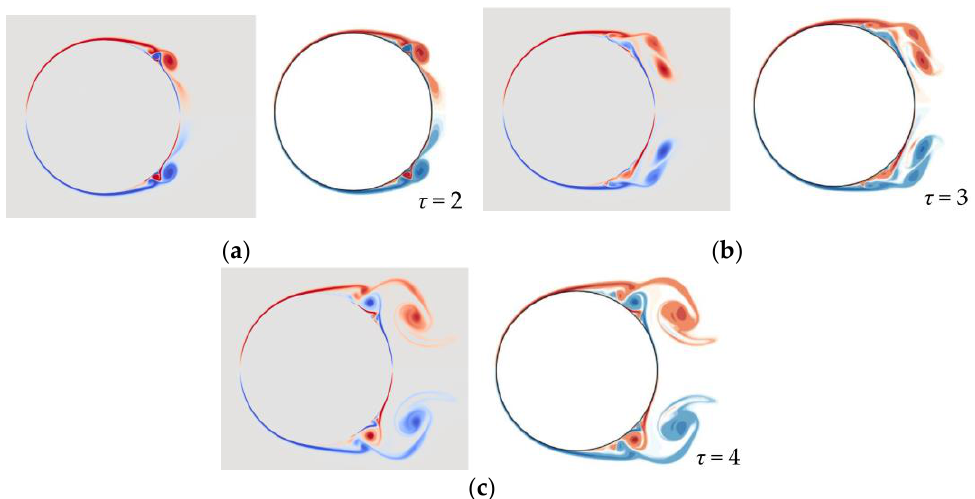
Figure 7. Vorticity evolution for impulsively started cylinder at Re = 9500: ( a ) τ = 2; ( b ) τ = 3; ( c ) τ = 4.